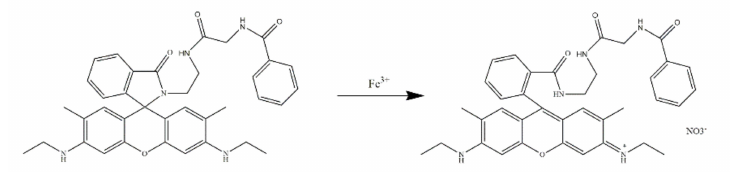
Figure 26. The proposed sensing mechanism of LXY (Table 1, No. 33) to Fe 3+ [62]. A filter paper grafted with rhodamine B (paper-g-RhBUEA) was reported to detect Fe 3+ via fluorescent and colorimetric assay by Liu X., et al. (Table 1, No. 34) [63]. The sensor paper-g-RhBUEA realized the on-site detection of Fe 3+ using a self-developed smartphone mini application named “Colorimetric detector”. In addition, the fast visual detecting device paper-g-RhBUEA was successfully applied to the on-site detection of Fe 3+ in environmental water samples. Cuc T. T. K., et al. designed and synthesized a multi- stimuli responsive rhodamine-based sensor, pseudo [3] rotaxane NI-DBC/RB-DBA (Table 1,